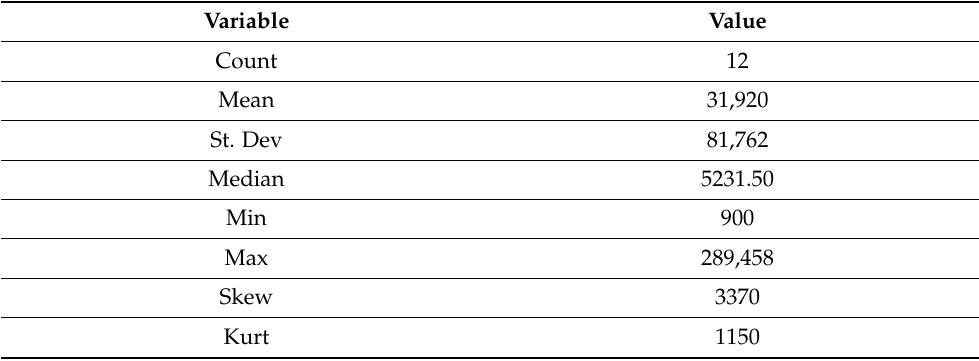
Table 4. Results of a descriptive test for total monthly tweets for #FeesMustFall from October 2015 to September